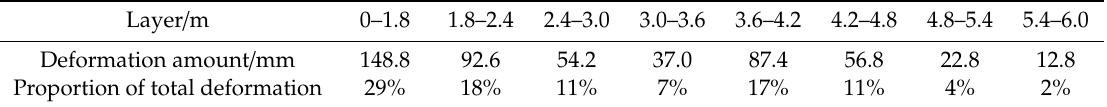
Figure 11. Curves of roadway roof deep displacement of Station I. Table 3. Distribution of roof deformation in each layer of Station I.